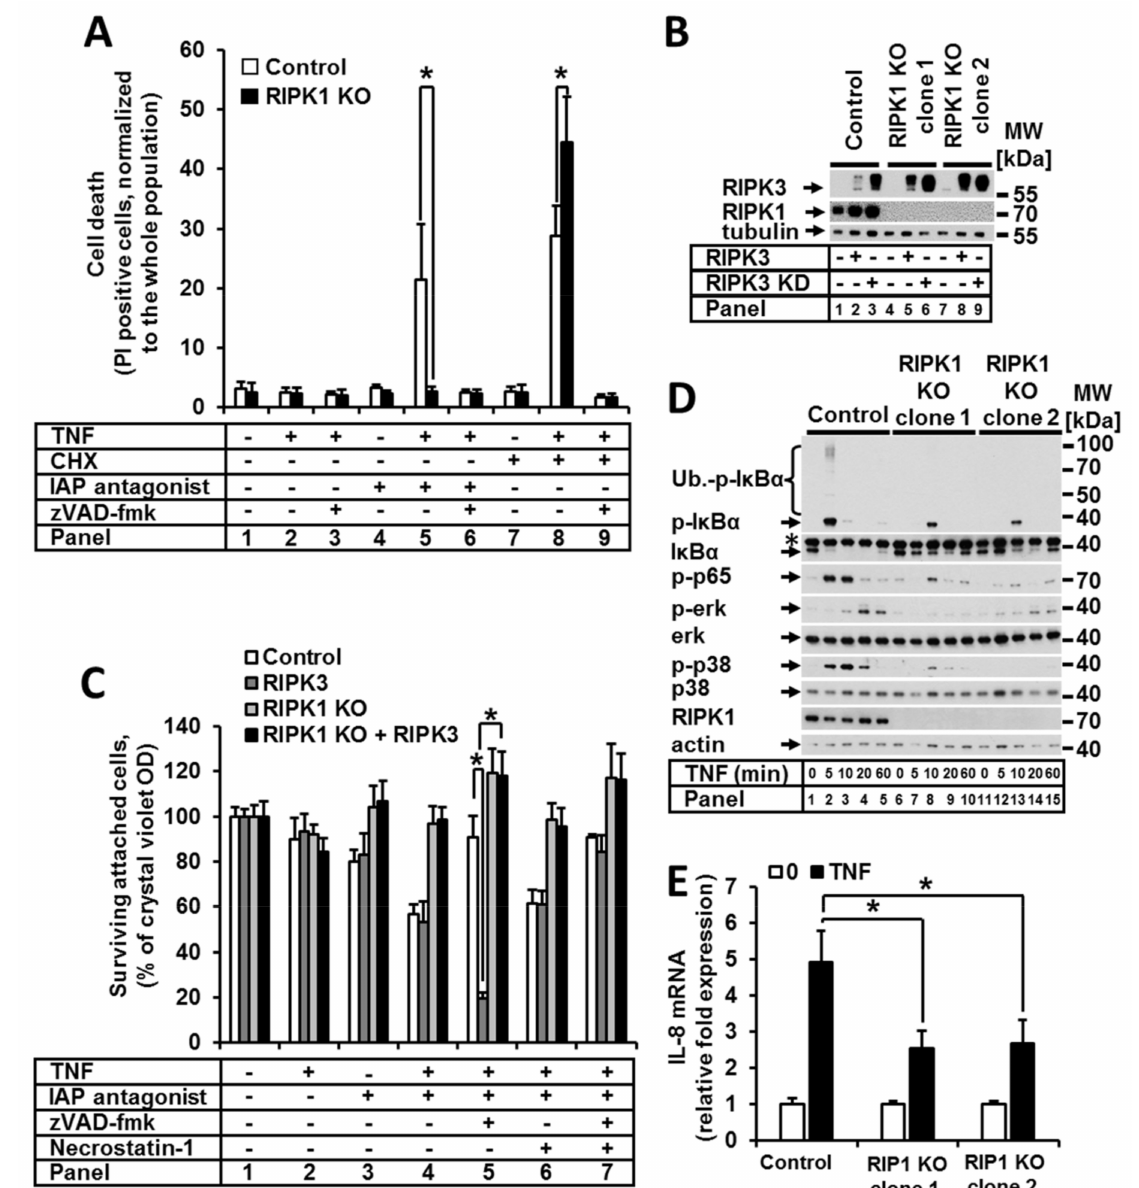
Figure 1. RIPK1 promoted TNF-induced apoptosis and necroptosis and non-cell death signaling. ( A ) RIPK1 KO HeLa and control cells were treated as shown, and cell death was analyzed by PI staining and FACS analysis. ( B ) Protein expression in control cells and RIPK1 KO clones overexpressing RIPK3 or RIPK3 KD was analyzed by WB. ( C ) The cells from ( B ) were treated as described and cell viability was analyzed by CV staining. ( D ) Control cells and RIPK1 KO clones were treated with TNF for the indicated time points, and cell lysates were analyzed by WB. ( E ) Control cells and RIPK1 KO clones were treated with TNF for 1 h, and mRNA expression of CXCL8 (IL-8) was analyzed by real-time qPCR. For each diagram, the mean values ( ± SEM) of three independent experiments are shown. The WB shown are representative of at least two independent experiments. Error bars represent the SEM. * p <